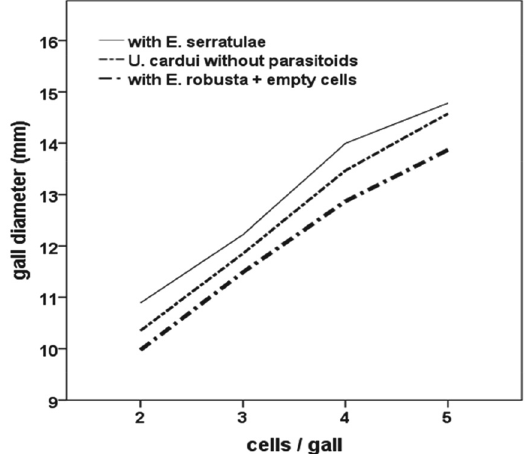
Figure 10. Average gall diameter in galls with E. serratulae (3512 galls), with unparasitized U. cardui (3449 galls) and with E .robusta plus empty cells (4288